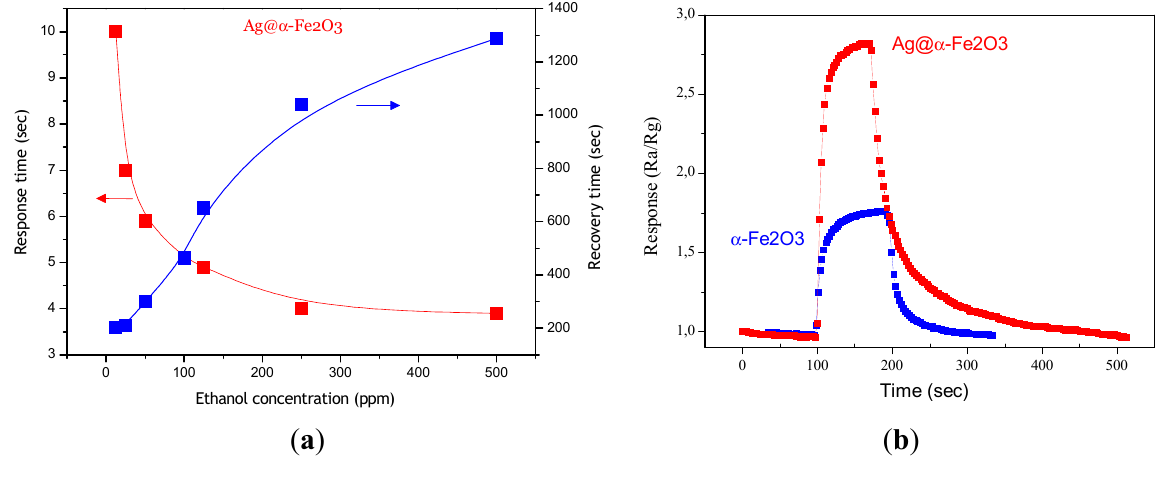
Figure 7. ( a ) Sensing response of Ag@ α -Fe 2 O 3 and α -Fe 2 O 3 towards different concentrations of ethanol vapor at 250 °C; ( b ) Linear relationship of log S-log C for Ag@ α -Fe 2 O 3 and α -Fe 2 O 3 sensors.